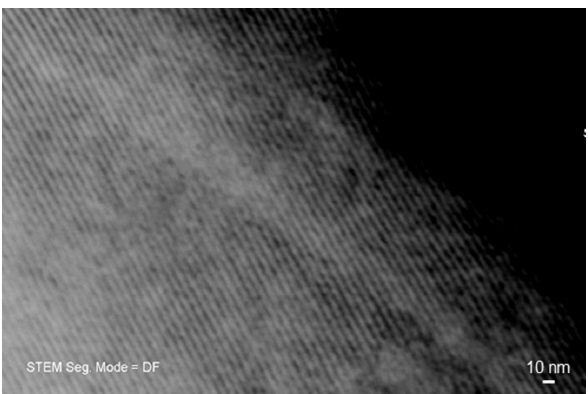
Figure 4. Scanning-transmission (STEM) image of 5Cu-glass recorded along the [100] direction, showing a parallel arrangement of nano-sized channels (mesopores).